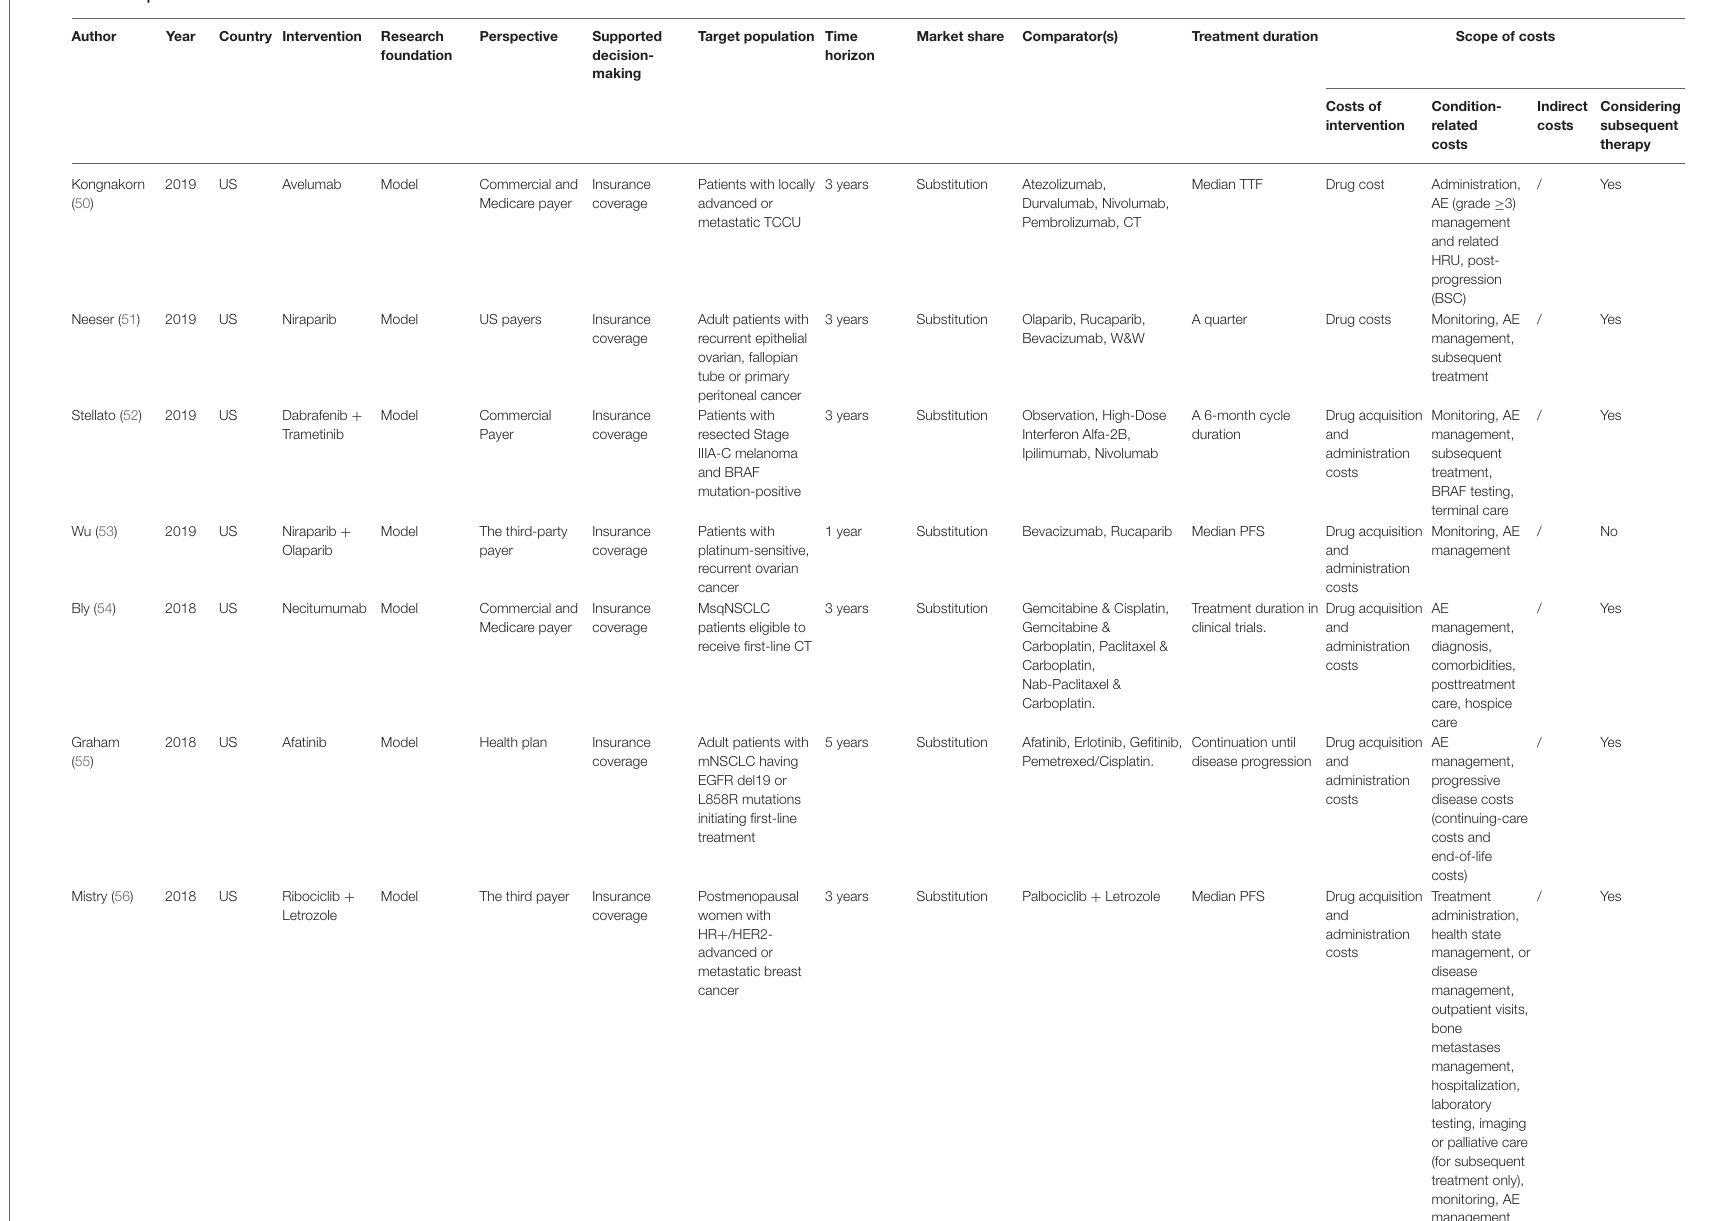
Afatinib, Erlotinib, Gefitinib,